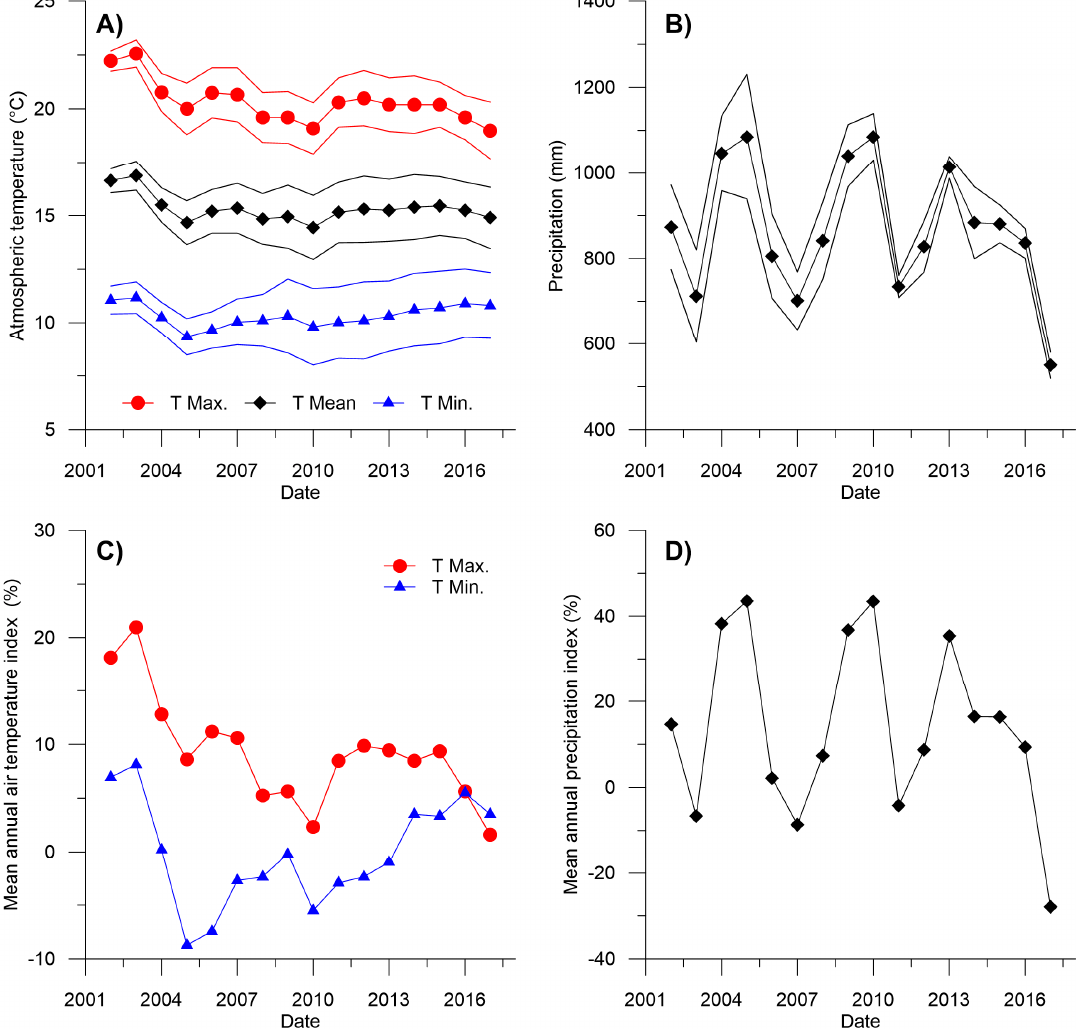
Figure 2. ( A ) Annual mean, maximum and minimum air temperatures recorded in the study area from 2002 to 2017 and their standard deviations, plotted as upper and lower lines. ( B ) Annual mean precipitations recorded in the study area from 2002 to 2017 and their standard deviations, plotted as upper and lower lines. ( C ) Mean annual maximum and minimum air temperature indexes (MATI) and ( D ) mean annual precipitation index (MAPI) for the Campania region.